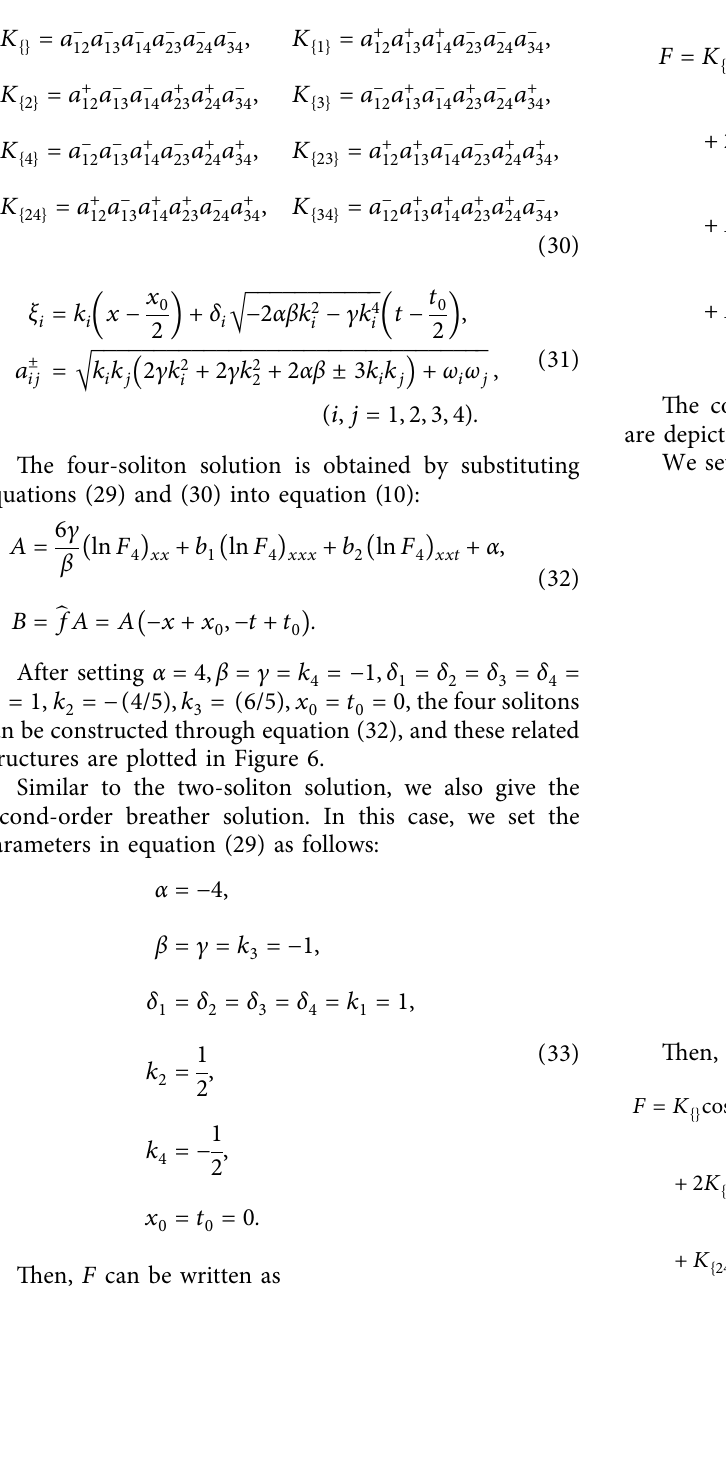
� b � 0; (b) and (c) b 1 2